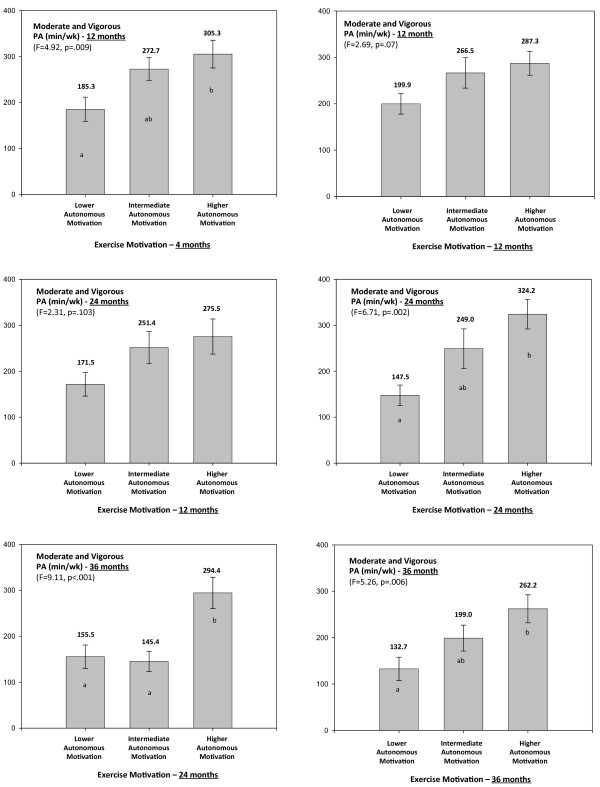
Title. Self-reported minutes of moderate and vigorous exercise per week as a function of exercise autonomous motivation. Analysis includes 141 participants of the PESO trial [67] and data reports to variables assessed at 12 months (intervention end), 24 months (1 year follow-up with no contact) and 36 months (2-year follow-up). The time-point values in exercise and motivational variables at each assessment period were used (not change). Values used for tertile-split groups of autonomous motivation were calculated including all subjects (intervention and control groups collapsed), adjusting for experimental group membership. Autonomous motivation includes the identified regulation and intrinsic motivation subscales of the Exercise Self-Regulation Questionnaire[84]. Self-reported exercise was assessed with the 7-day Physical Activity Recall interview [25] and quantifies moderate and vigorous structured physical activity (METs > 3) performed in the previous week (or typical of the previous month if previous week was atypical, see reference 27 for more details). Panels B, D, and F show cross-sectional associations (variables assessed at the same time point) and panels A, C, and E show “prospective” associations (motivation assessed one year earlier than exercise). F for one-way ANOVA with letters in bar indicating multiple comparisons with Bonferroni post-hoc tests (different letters indicate different means, p < .05).